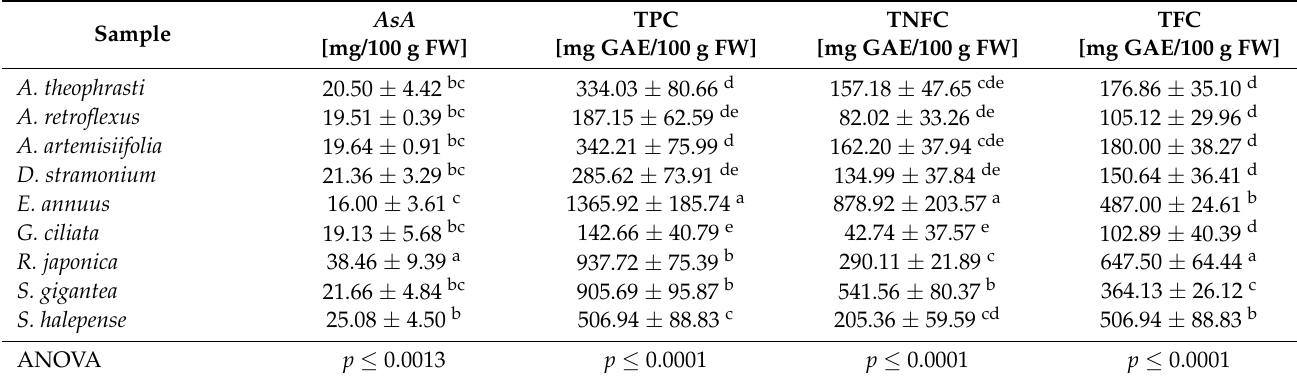
Table 1. Bioactive compounds content obtained from invasive plant species